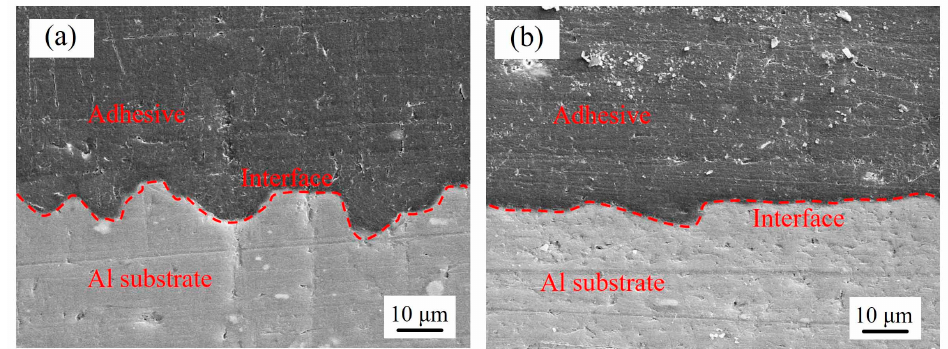
Figure 16. Cross-sections of adhesive-bonded joints of substrate with different treatments: ( a ) PAA process 1 and ( b ) sandpaper abrasion.